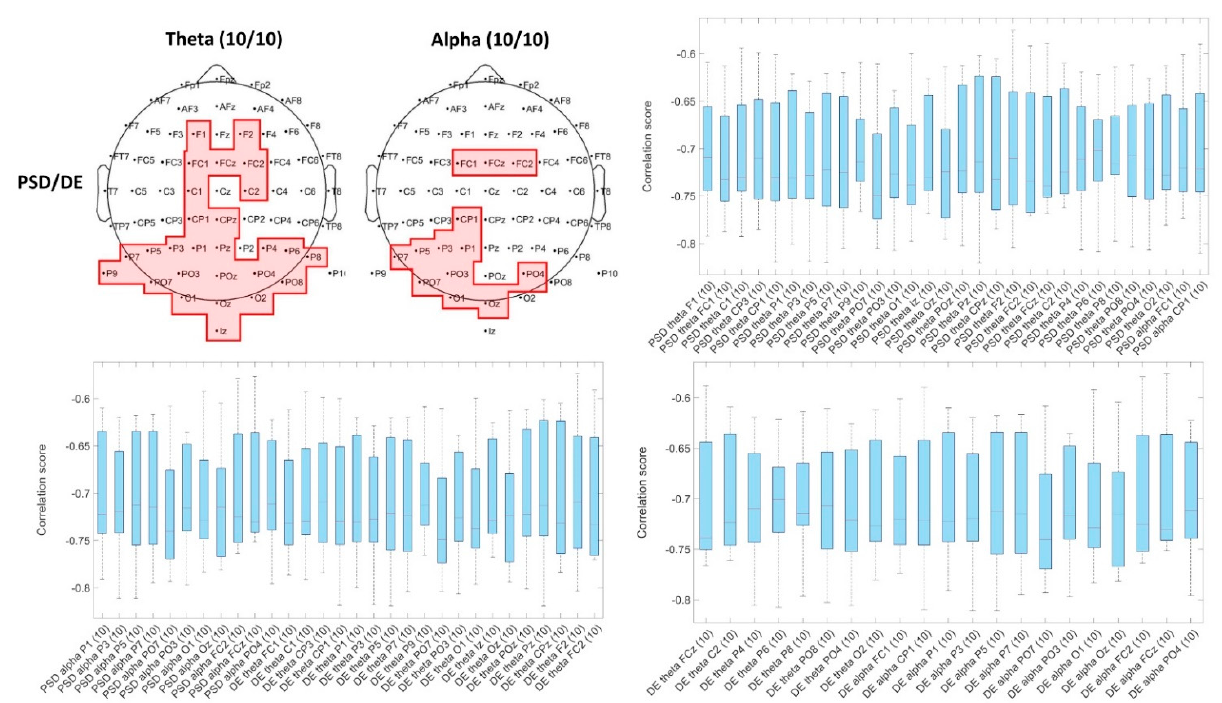
Figure 6. EEG traits correlated with game events. Theta band’s PSD and DE from electrodes on the occipital and central brain region and, alpha band’s PSD and DE from electrodes on the frontal-central and the occipital brain regions. The EEG traits had a negative correlation with positive events and positive correlation with negative events.